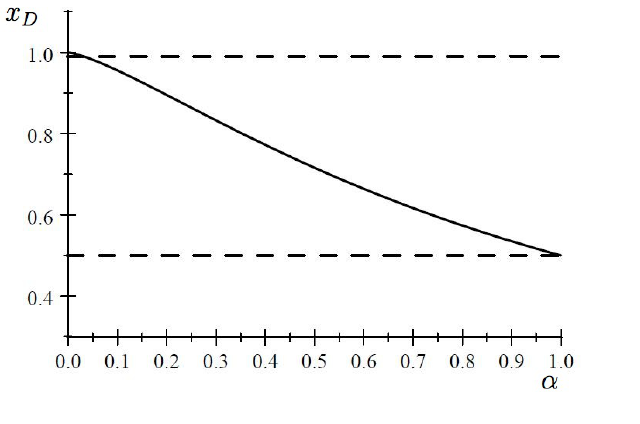
Figure 2. The optimal one-shot deviation for altruists in the repeated